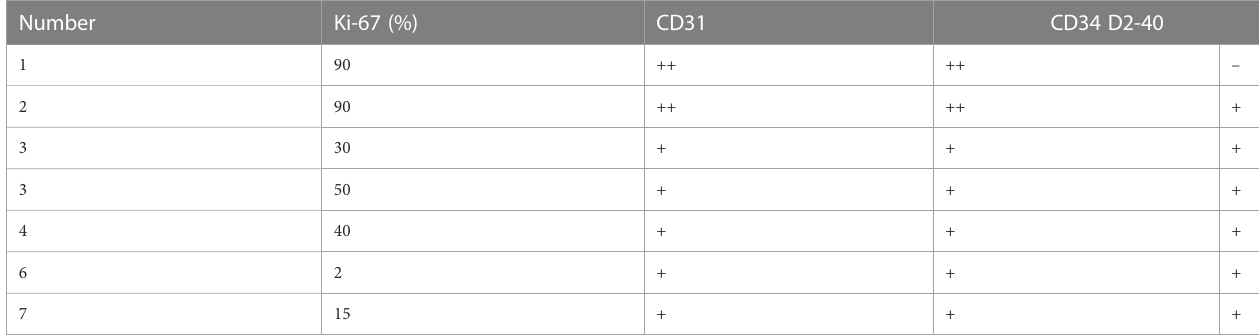
TABLE 4 Immunohistochemical results of the patients with